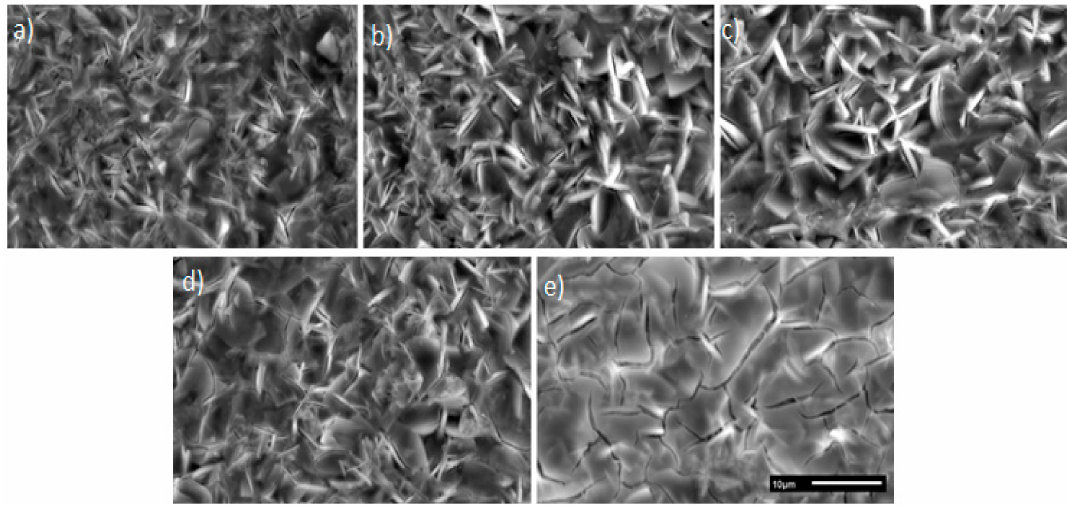
Figure 10. Scanning electron micrographs of coatings surface on phosphated zinc: ( a ) TEOS/MAP; ( b ) TEOS/(75%MAP + 25%UPS); ( c ) TEOS/(50%MAP + 50%UPS); ( d ) TEOS/(25%MAP + 75%UPS); and ( e ) TEOS/UPS (same scale bar of 10 µ m for all images).